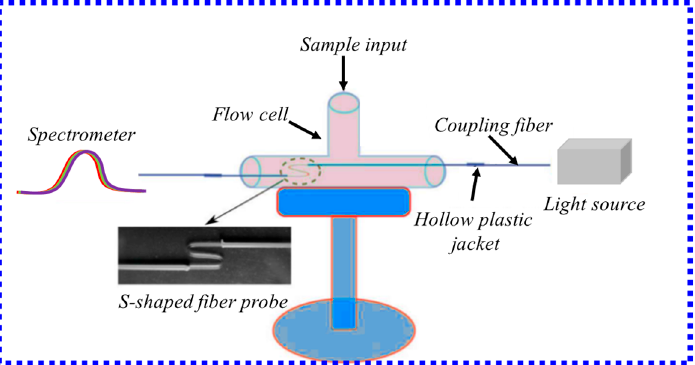
Figure 12. Schematic diagram of S-type optical fiber sensing device [85]. Copyright 2023, Elsevier.